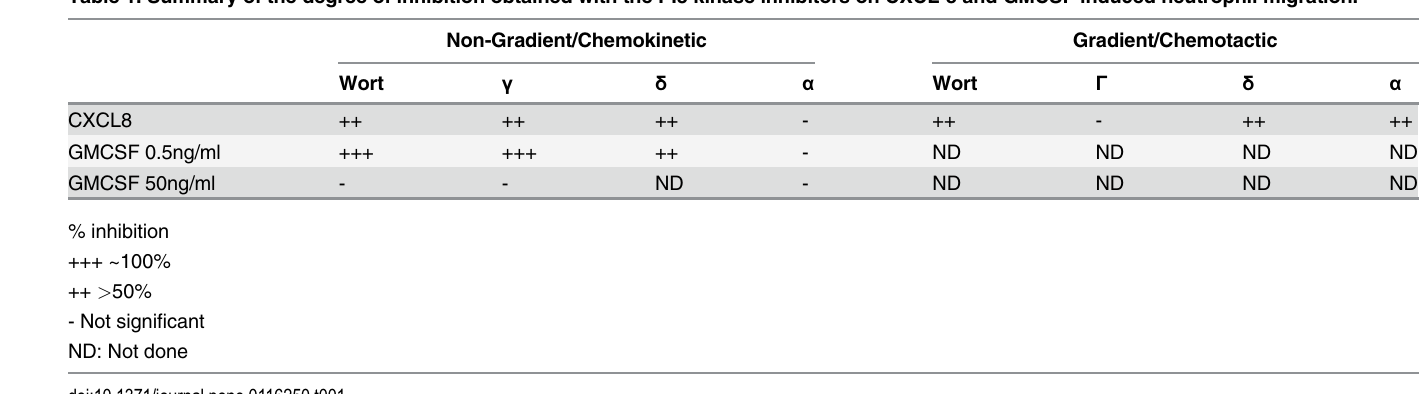
Table 1. Summary of the degree of inhibition obtained with the PI3 kinase inhibitors on CXCL-8 and GMCSF induced neutrophil